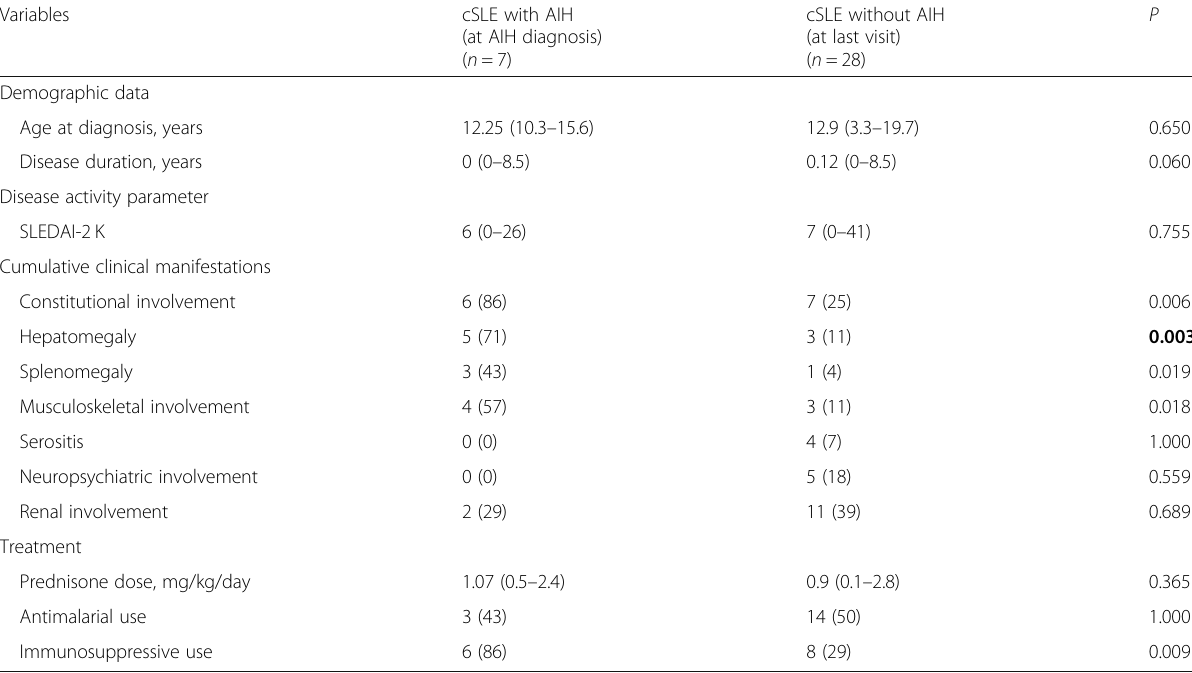
Table 2 Demographic data, disease activity, cumulative clinical manifestations and treatments in childhood-onset systemic lupus erythematosus (cSLE) patients with autoimmune hepatitis (AIH) at diagnosis compared to those without AIH evaluated at last